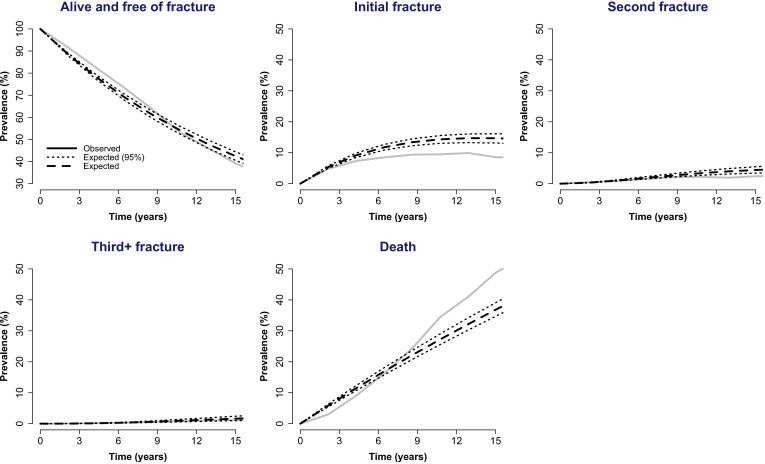
Assessment of goodness-of-fit of the analysis model for each of five heath states: alive and free of fracture, initial fracture, second fracture, third and further fracture, and death.Grey curve shows the observed prevalence of each heath state while the expected values are shown in dashed black curve with 95% confident interval (dotted grey curves).Figure 3—figure supplement 2—source data 1.Assessment of goodness-of-fit of the analysis model: Observed and expected prevalences of each heath state.